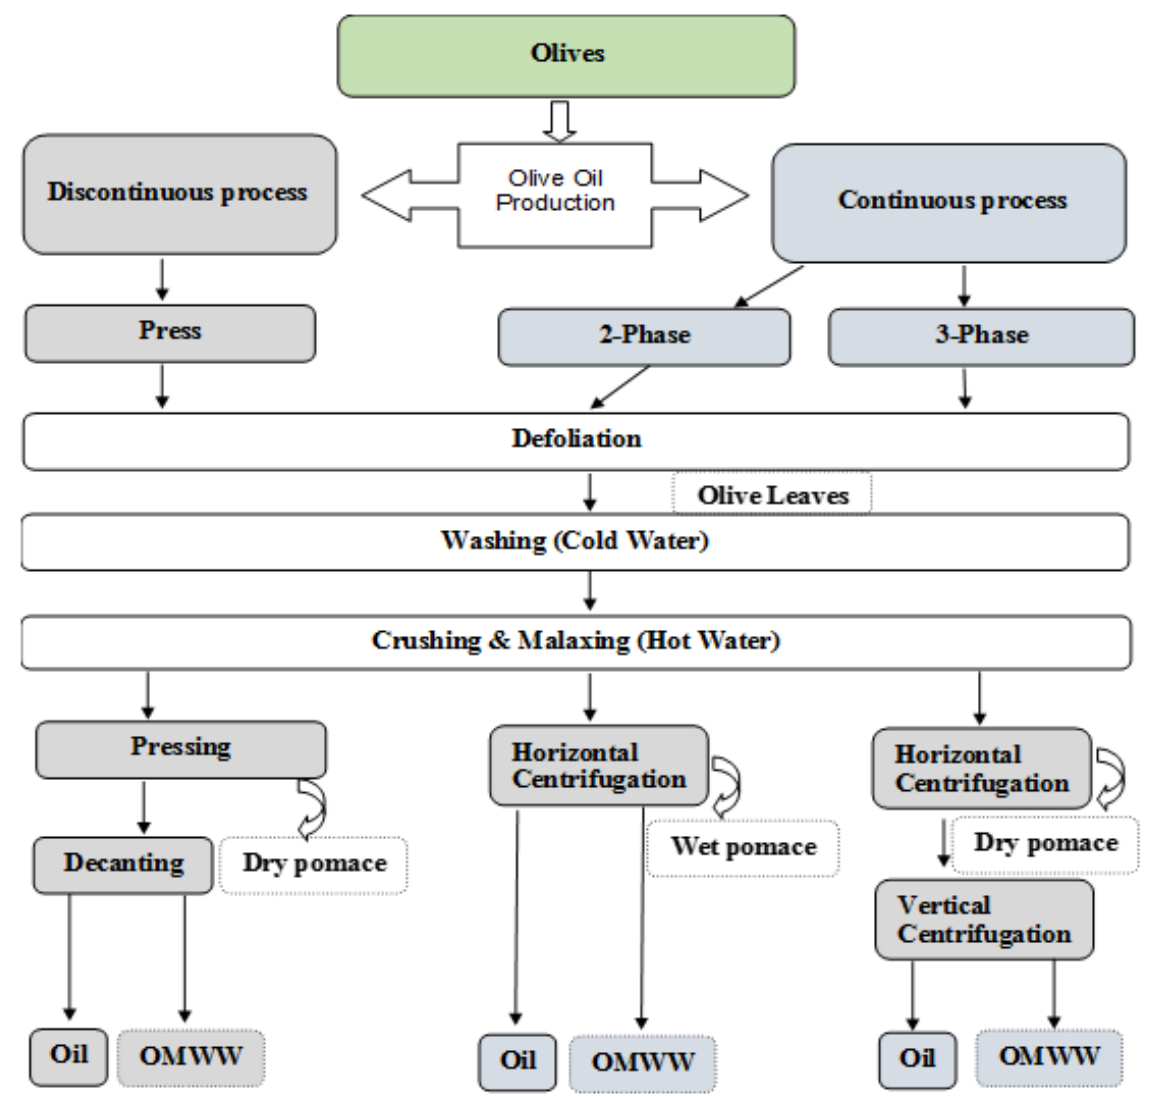
Figure 2. Scheme of discontinuous and continuous extraction systems. OMWW = olive mill wastewater according to Sakar and Gharby [17]. AO is a traditionally extracted olive oil following an ancestral method derived from heritage similar to that used in food argan oil extraction [18]. About 5 kg of olive fruits (BBCH 89), as previously described, were obtained from a local olive grove of ‘Moroccan Picholine’ cultivar conducted under rainfed conditions. Roasting was carried out in a ventilated oven (Precision Scientific Co., Waltham, MA, USA) for 12 h at a temperature not over than 120 ◦ C. After that, roasted olives were ground, according to a local practice, between two stones. Small amounts (about 250 mL) of hot water were thereafter added to the mixture gradually until reaching a paste. Roasting allows the manufacturer to decrease olives’ moisture level and therefore makes grinding more efficient with low particle size, volume surface mean diameter, specific energy consumption, etc., as evidenced in Mohite et al. [19]. The obtained paste was poured into a 4.75 mm IS sieve (ASTM No. 4) and pressed for 3 h using a traditional press. For 5 kg of fruits, 700 mL of AO were obtained. The oil was kept at 4 ◦ C for further